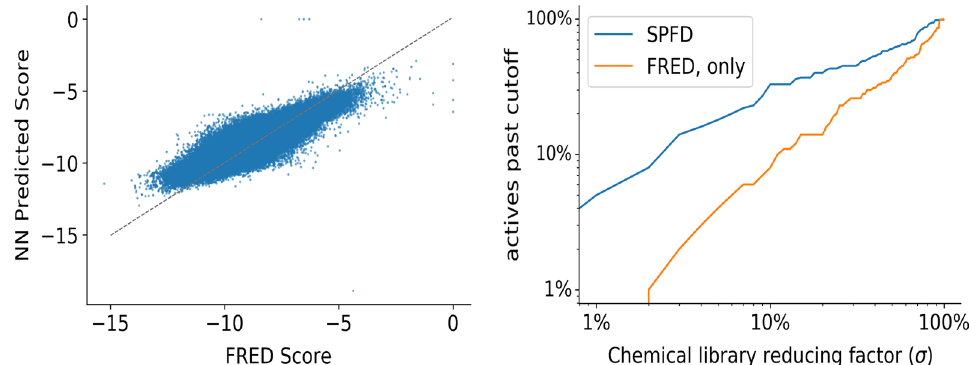
Figure 4. (left) Scatter plot illustrating correlation between the predicted scores and the FRED scores (for 3CL-main protease on a 100,000 random subset of orderable MCule molecules). (right) Detection of active compounds from NCATS (AC50 ≤ 10 µ M) with SPFD (predicted with NN) and FRED (docking). SPFD detects all active compounds which FRED detects for 3CL-main protease and therefore is a faster alternative to regular docking without loss of active detection. This indicates the differences between the predictions and the actual FRED scores lean towards detecting actives.